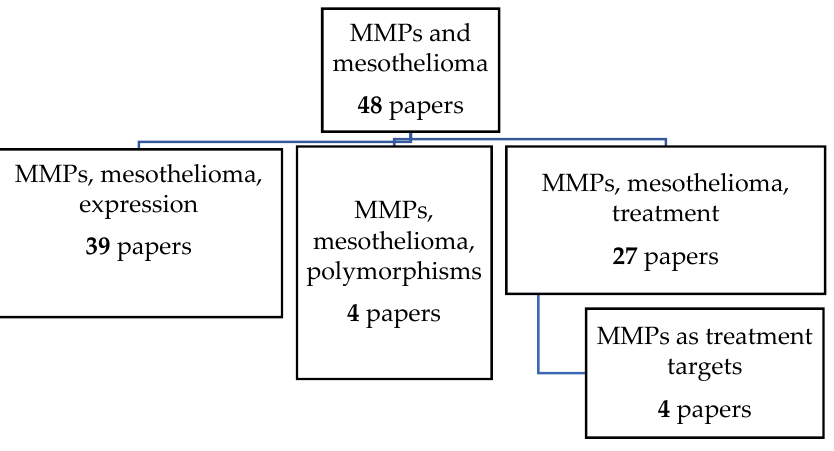
Figure 1. Stratification of papers considered in this review.